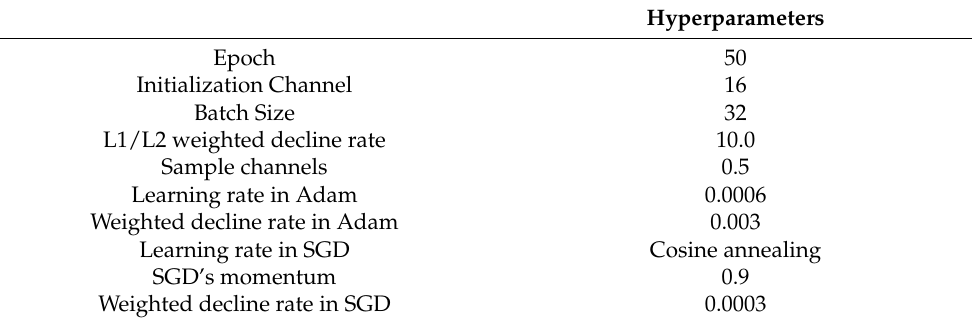
Table 4. Hyperparameter setting for structural search phase of neural network.